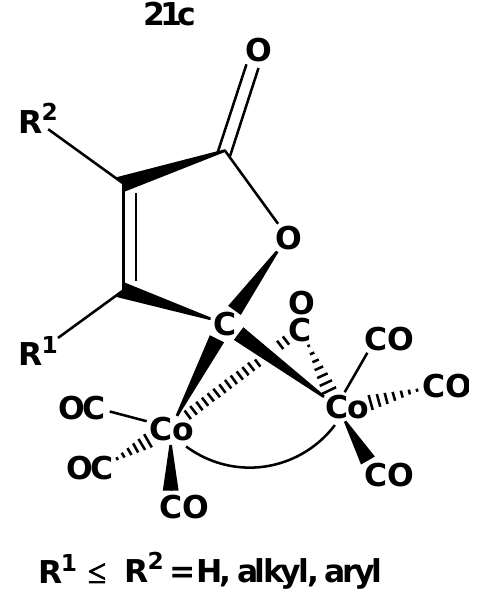
Figure 14. Schematic view of the structure of complex 21c [65,66]. For 21a and 21b see Figures 1 and 2, respectively.